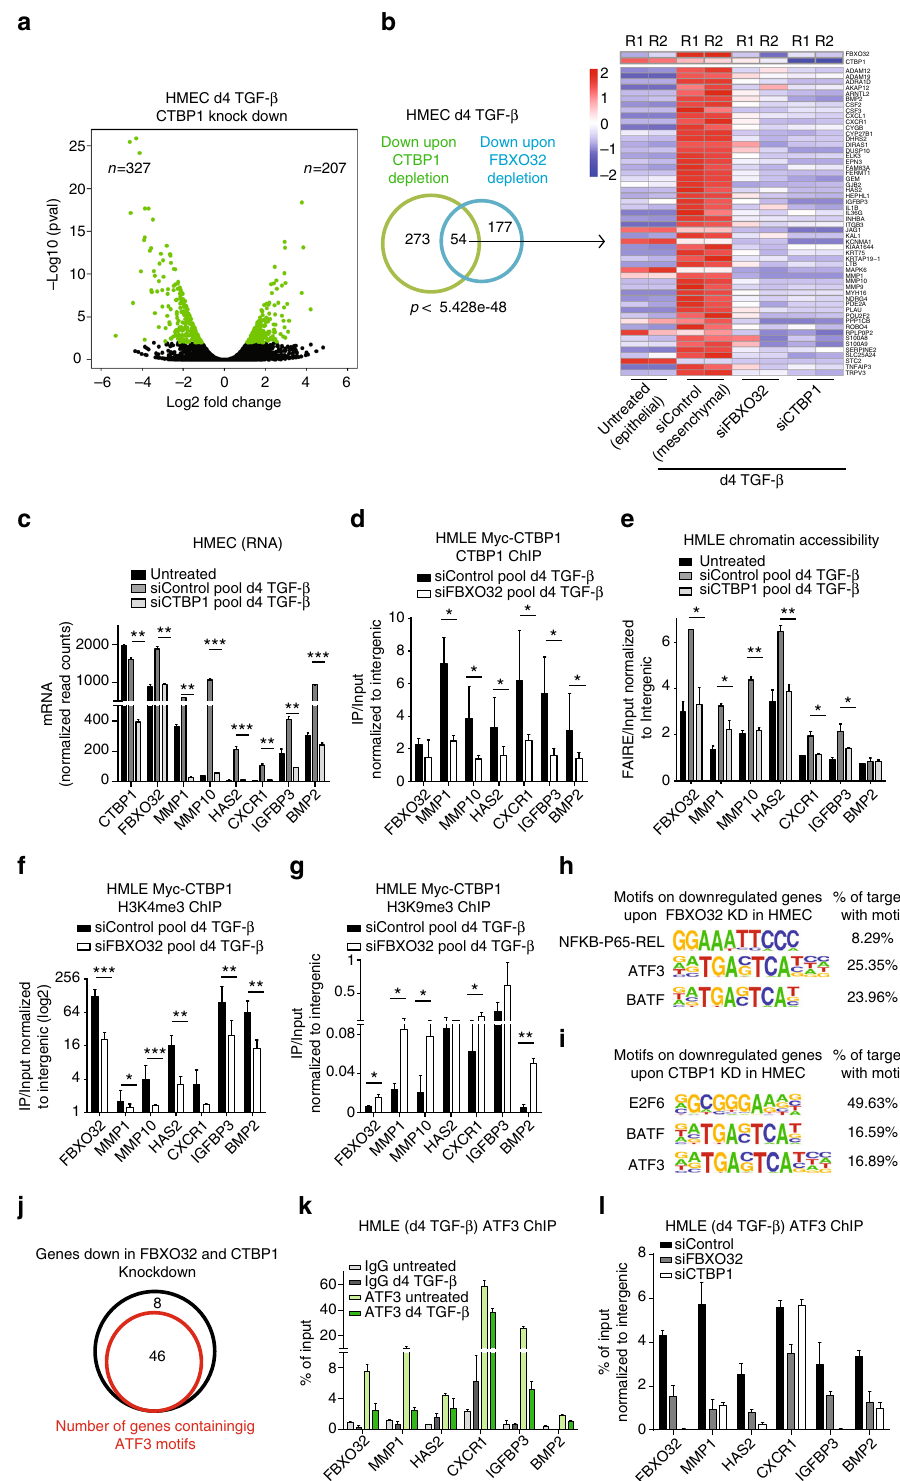
FAC-sorted CD133+ (VZ population) and NCAM+ cells (neu- ronal populations) (Fig. 5d). In addition, the transcriptional dynamics of Fbxo32 was con fi rmed by RNA in situ hybridization datasets in the developing mouse cortex (Fig. 5e). Such Fbxo32 upregulation during neuronal EMT in vivo also accompanied the induction of previously identi fi ed Fbxo32-dependent EMT-rele- vant genes (Supplementary Fig. 8).